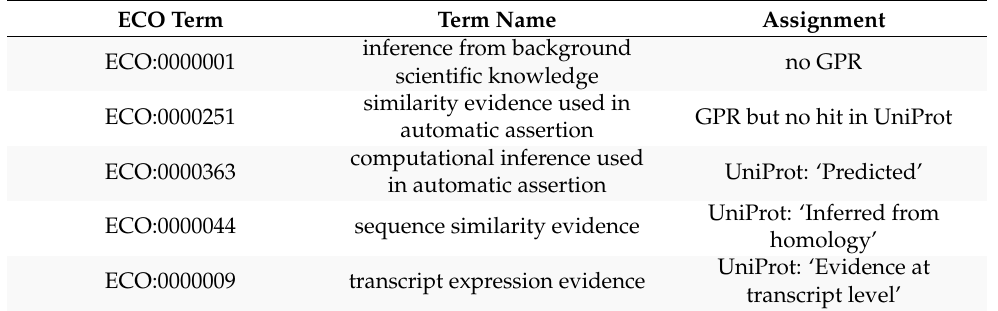
Table 3. ECO terms and their names and assignments. For every Evidence and Conclusion Ontology (ECO) term, the corresponding name is given together with the assignment. ECO terms are ordered in ascending evidence